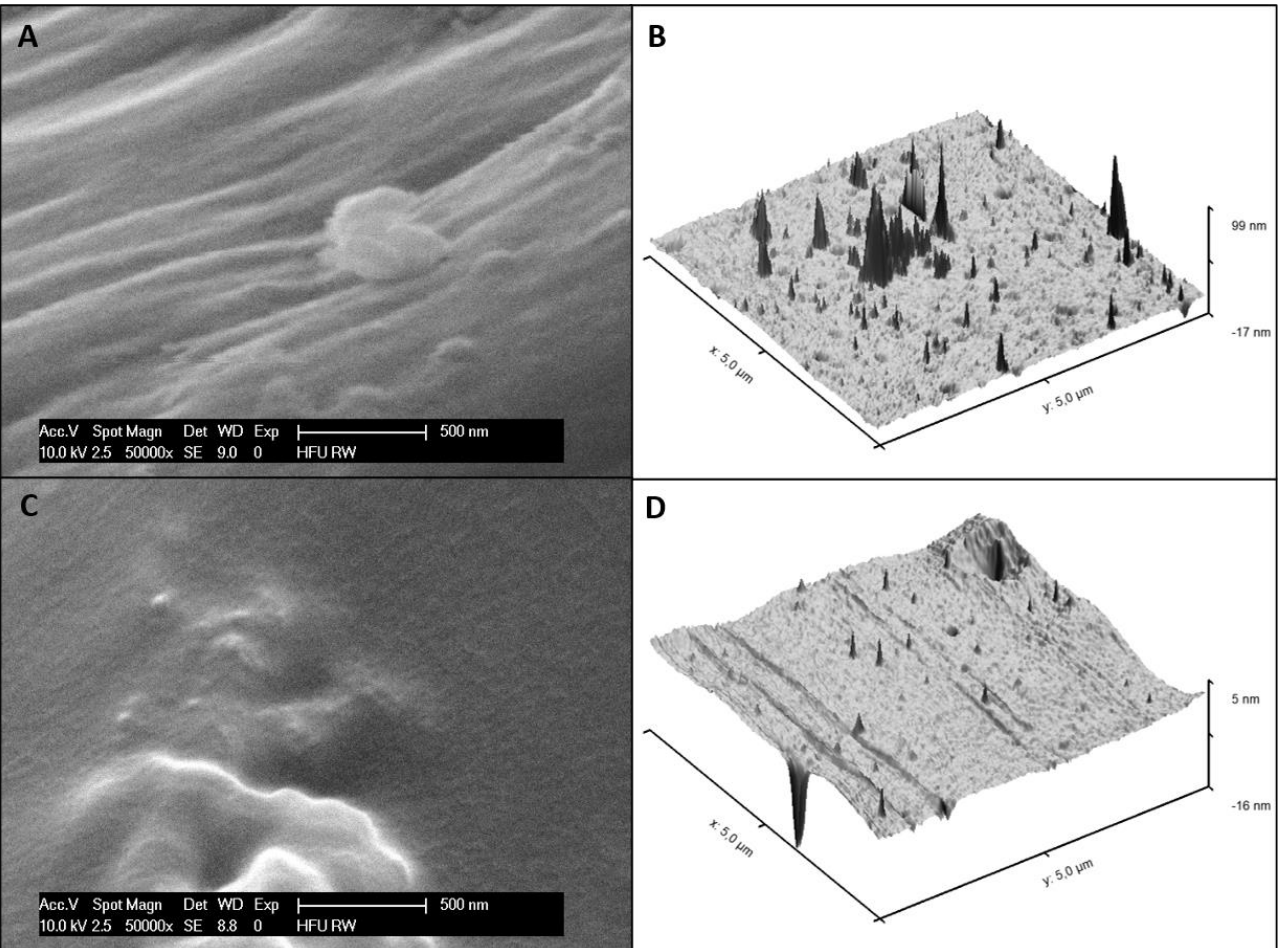
Figure 4. SEM ( A,C ) and AFM ( B,D ) images of the bioactive PDMAm coatings, 5%-GlcNAc-4EG ( A,B ) and GlcNAc-6EG ( C,D ).